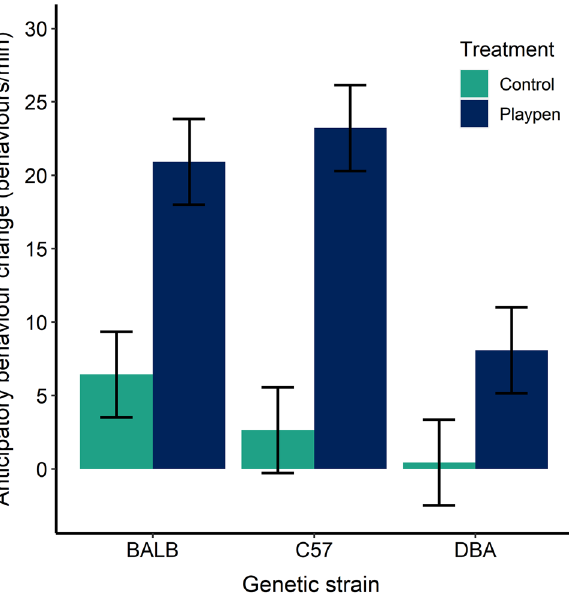
Figure 3. Change in anticipatory behaviour (mean behavioural frequency/min) from baseline (day 1) to experimental days (average of day 8–14). The plot shows LS means and standard error generated by the mixed model; n = 42 mice (14 mice per strain) and 7 cages per treatment.